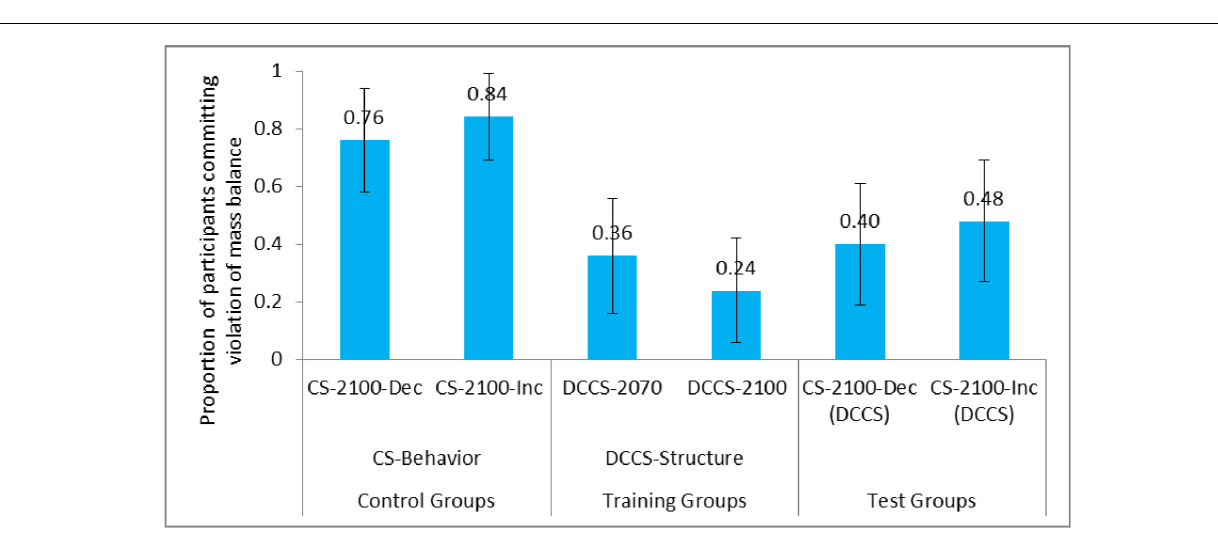
FIGURE 7 | Proportion of participants committing violation of mass balance in CS tasks and DCCS in CS-Structure and DCCS-Structure conditions. The CS-2100-Dec (DCCS) task and CS-2100-Inc (DCCS) task refer to CS tasks following the DCCS performance in the DCCS-Structure condition. The error bars represent 95% confidence interval around the point